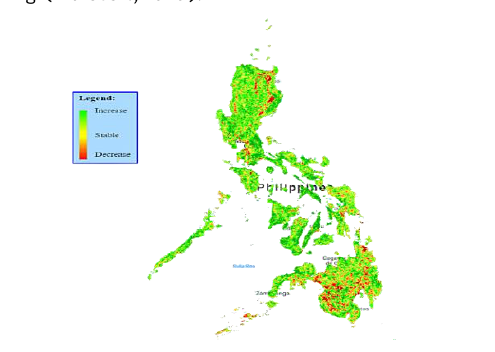
Figure 1. Cumulative EVI anomalies in the Philippines. The cumulative EVI anomalies plot is shown in Figure 2. There are negative cumulative EVI anomalies values from 2011-2012 which means that during the period, there was an overall reduction of vegetation in the country. After the 1 st quarter of 2012, the overall health of the vegetation in the country slowly increased as shown by the positive cumulative EVI anomalies values computed. The increasing value of the plot supports that there is an increase in vegetation in the Philippines (UN, 2021).